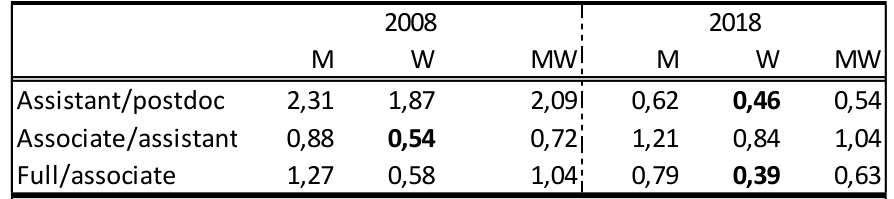
Table 3: Ratios by year and